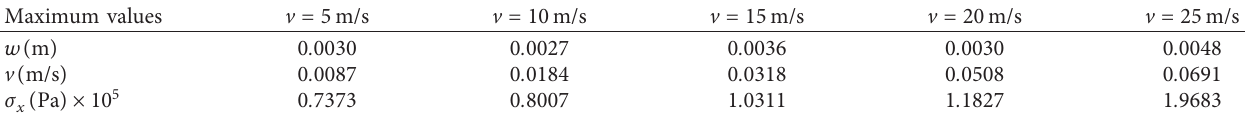
Table 5: Maximum deflections, velocities, and stresses at the central point of the FGP plate versus time. Maximum